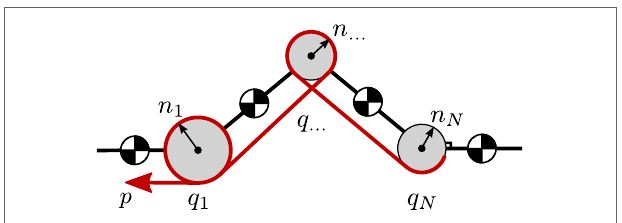
FIGURE 2 | Multiarticulation of a single tendon for an N -joint kinematic chain. The elastic tendon with pretension position p and stiffness k is shown in red.